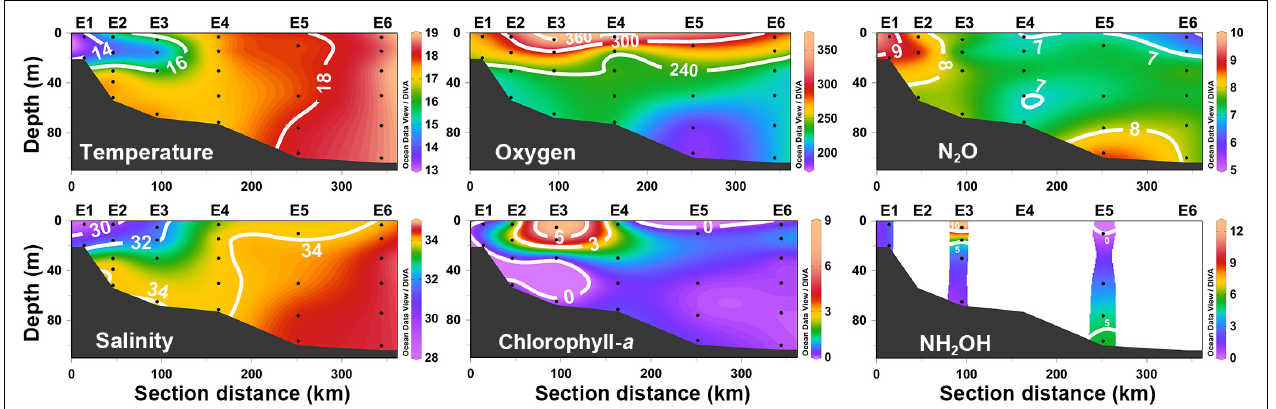
FIGURE 6 | The vertical distributions of temperature ( ◦ C), salinity (psu), dissolved oxygen ( µ mol L − 1 ), chlorophyll- a ( µ g L − 1 ), N 2 O (nmol L − 1 ), and NH 2 OH (nmol L − 1 ) along section E.